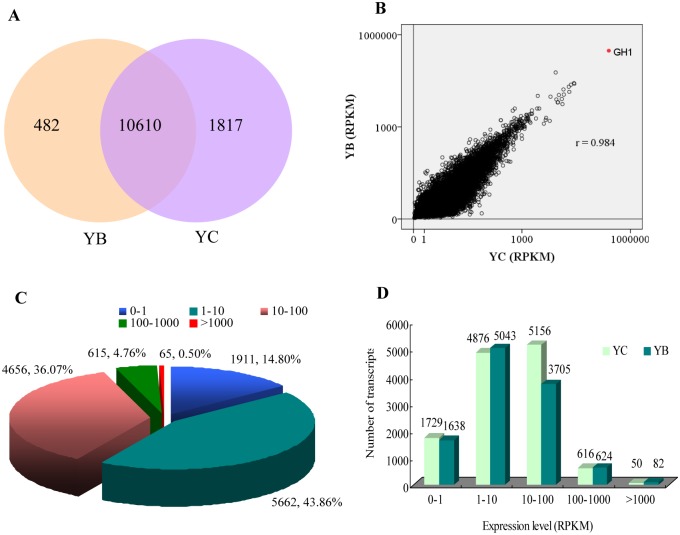
mRNA (transcripts) expression and distribution.(A) mRNA numbers of the two pig breeds. (B) Scatter plots of mRNA expression; r represents the correlation between Bama minipigs and Landrace pigs and the red dot GH1 was the most abundant transcript in both pig breeds. (C) The average expression level and proportion of mRNAs in the anterior pituitary. (D) The mRNA numbers of the two pig breeds at different expression levels. YB and YC indicate Bama minipigs and Landrace pigs, respectively.